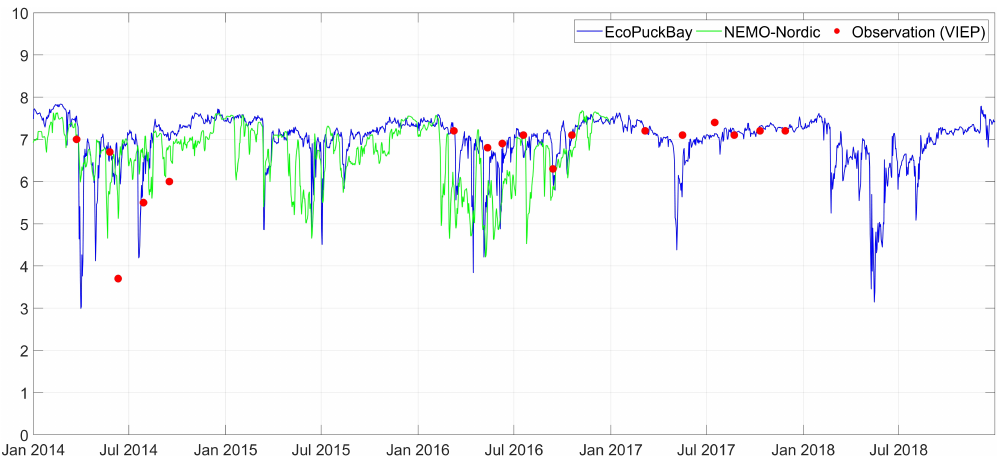
Figure A11. Time series of surface salinity on station T11 compared with VIEP observations and NEMO-Nordic model.